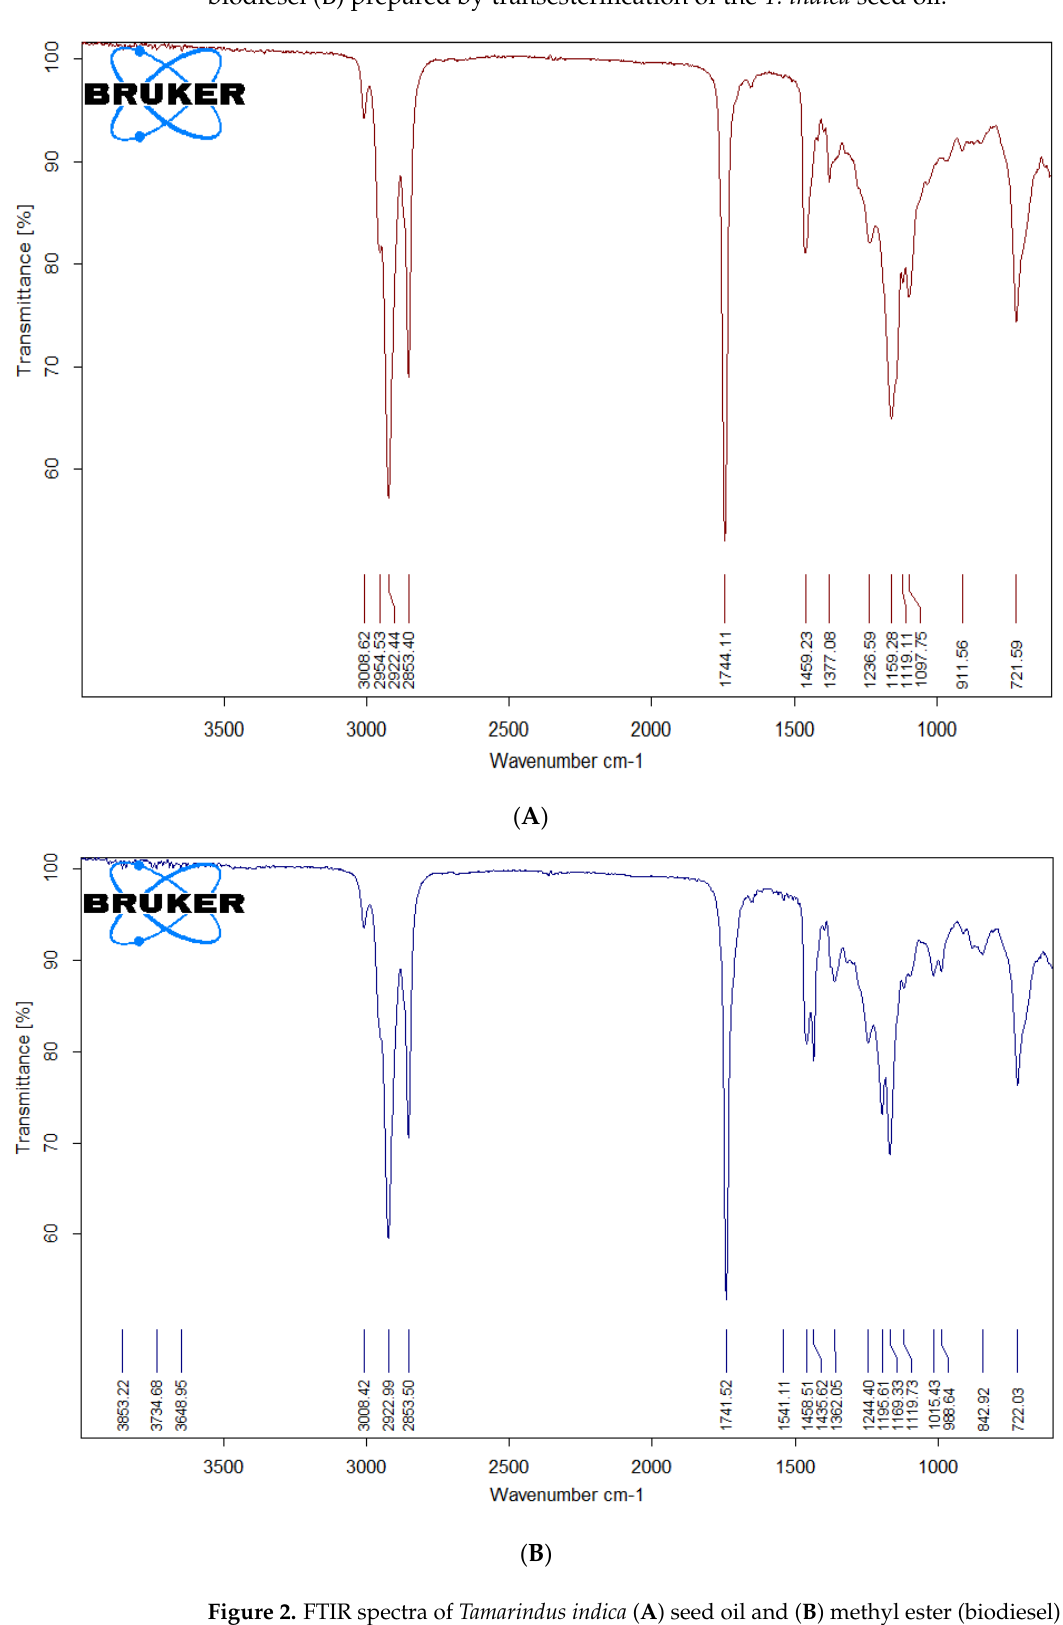
Figure 2. FTIR spectra of Tamarindus indica ( A ) seed oil and ( B ) methyl ester (biodiesel) representing different functionalities. Table 4. Fatty acid profile of T. indica seed oil.